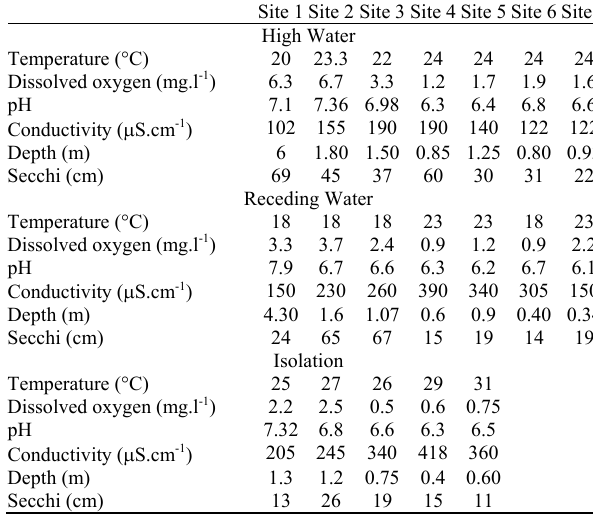
Table 1. Physical and chemical characteristics recorded in littoral areas of the study sites during different hydrological